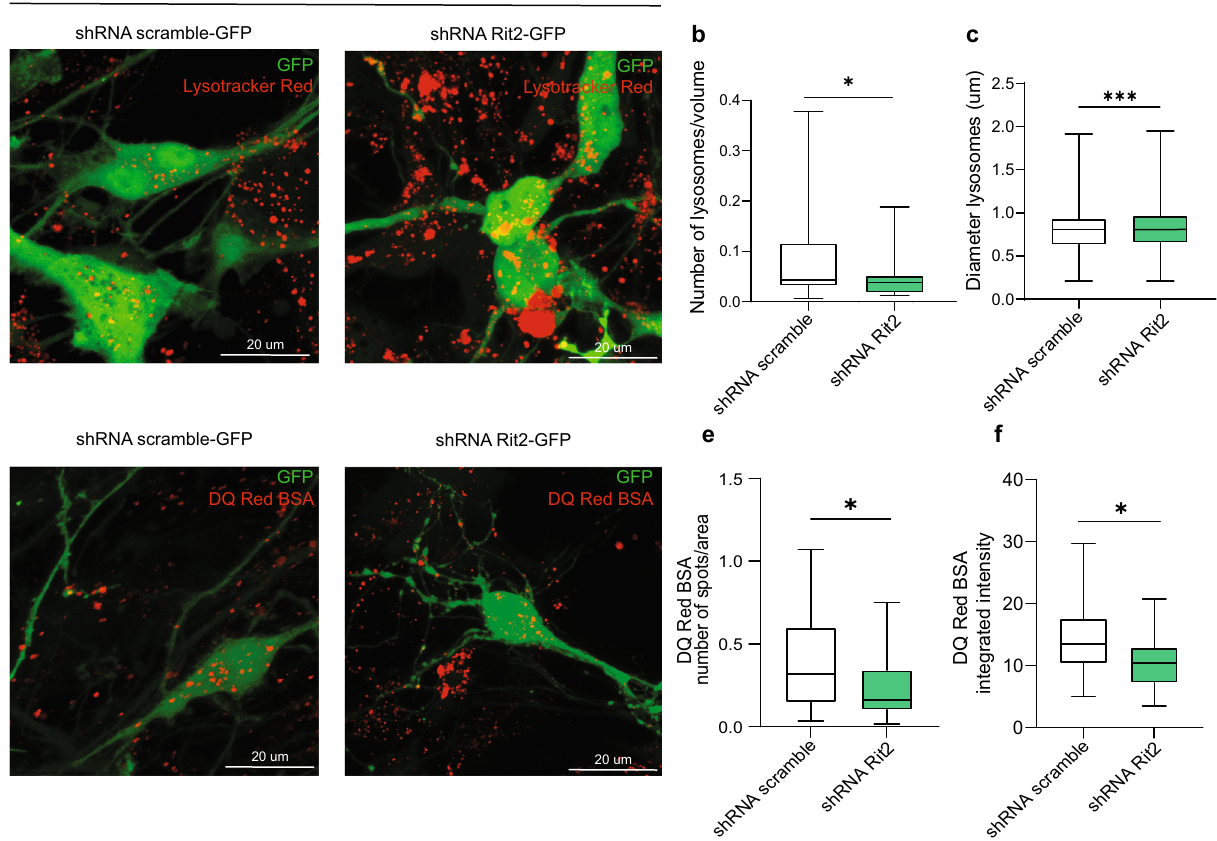
Fig. 9 Rit2 KD leads to abnormal lysosomal morphology and proteolytic activity in primary dopaminergic neurons. a Lysosomes were visualized with the Lysotracker Red dye in neurons. b The number of lysosomes per cell was quanti fi ed and revealed a decrease when Rit2 levels were reduced ( n = 3). c The average size of lysosomes was assessed, and a signi fi cant increase of the diameter was measured upon Rit2 KD ( n = 3). d The DQ-Red-BSA assay was employed to assess the proteolytic activity of lysosomes. e , f Quanti fi cation of DQ-Red-BSA fl uorescent spots revealed a signi fi cant decrease of number and intensity in Rit2 KD neurons ( n = 3). Data are represented as median, boxes show the IQ and whiskers show min – max. * p < 0.05, *** p < 0.001, unpaired two-tailed Student ’ s t